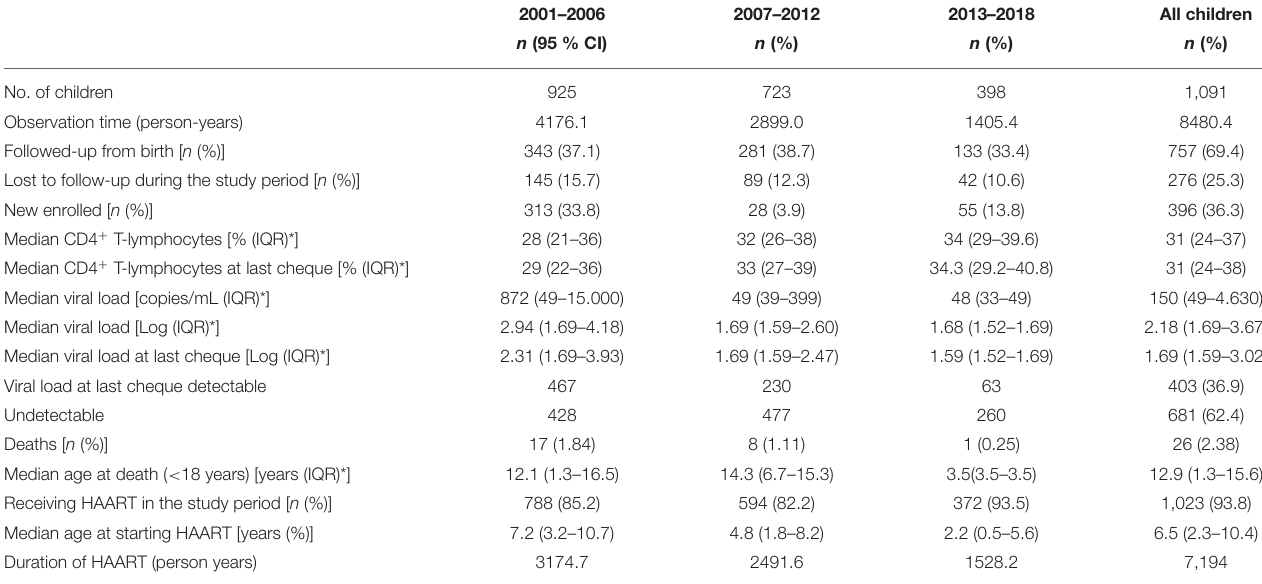
TABLE 1 | Characteristics of the 1,091 HIV-1 infected children, by calendar period of